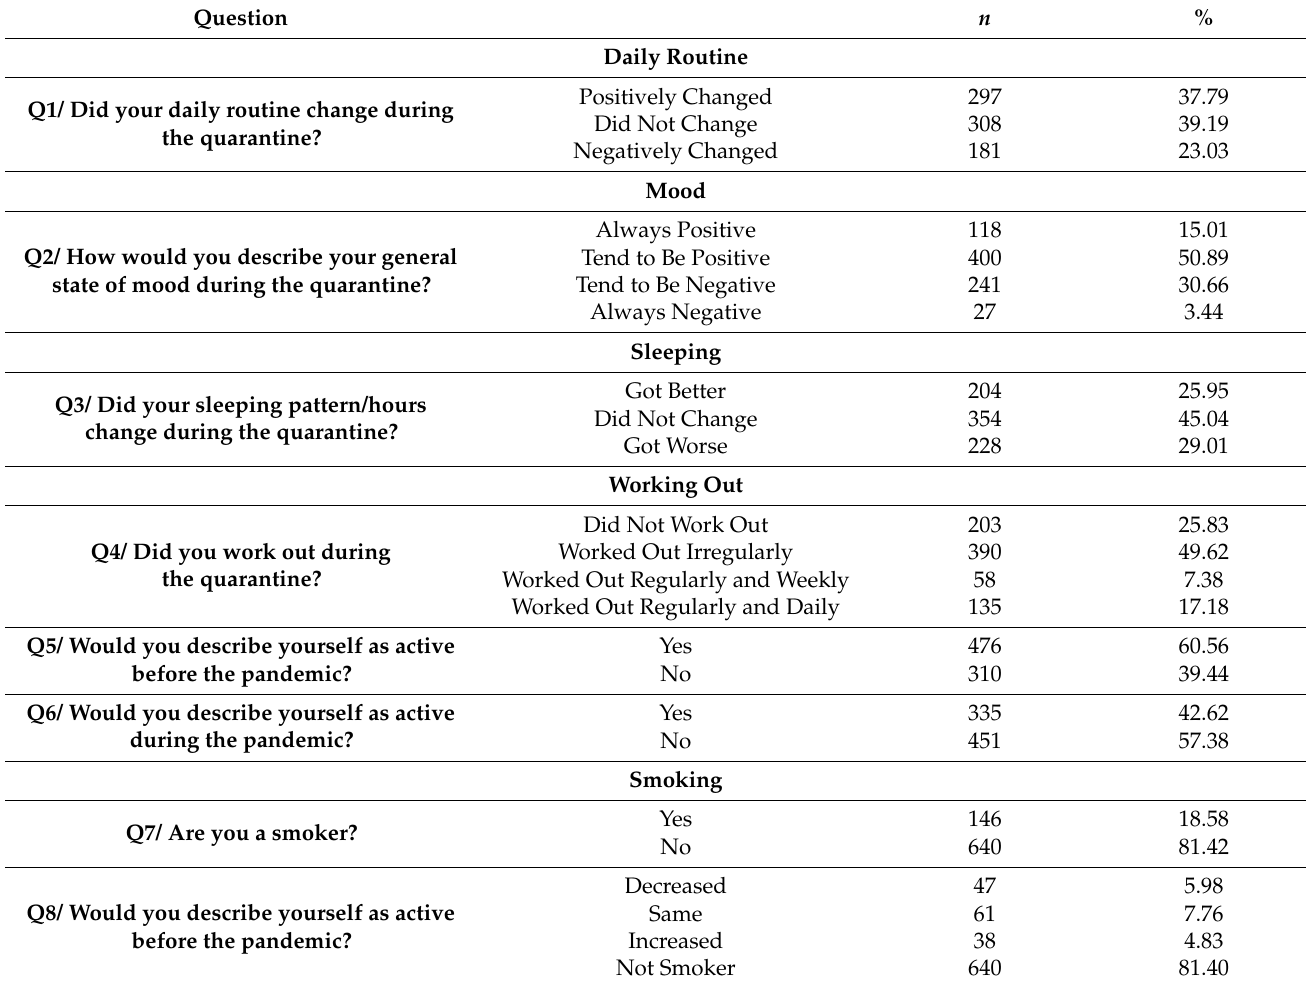
Table 2. Daily routine, mood, sleeping, physical activity, and smoking during the COVID-19 pan- demic ( n =